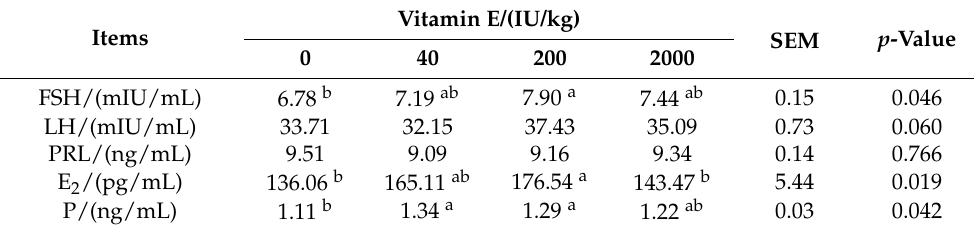
Table 4. Effects of dietary vitamin E supplementation on plasma reproductive hormones in breed- ing geese 1